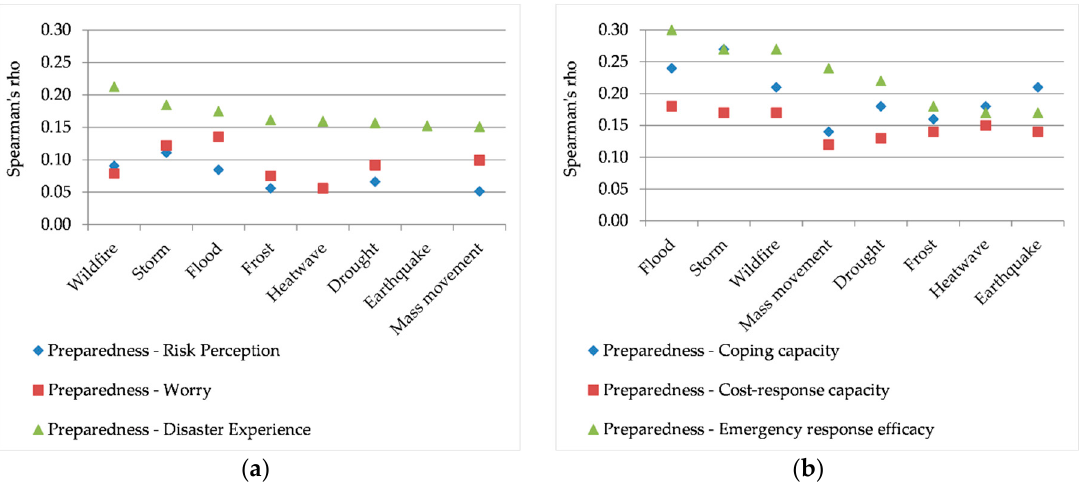
Figure 9. Correlation strength (Spearman’s rho) between preparedness and: ( a ) Risk perception, feelings of worry, and disaster experience, ( b ) coping appraisals, across all hazard types (only significant results are depicted, p < 0.05).